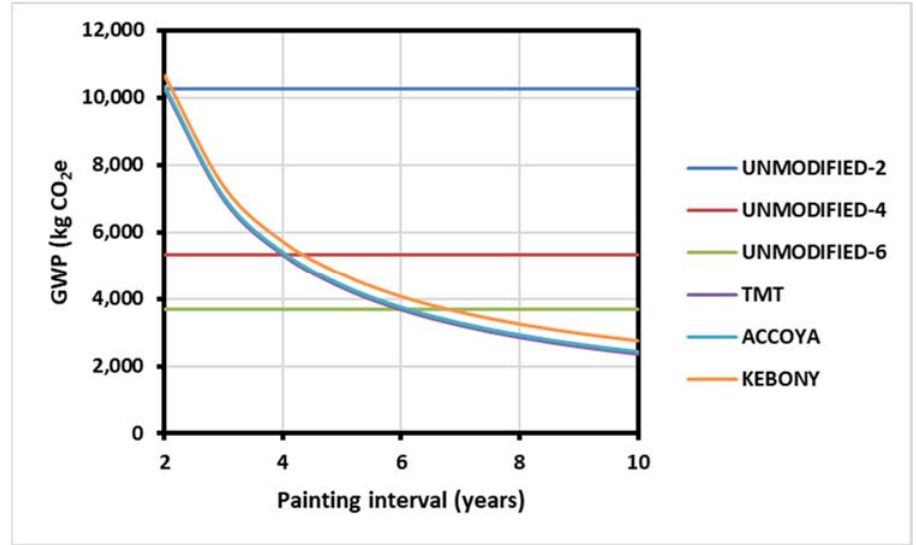
Figure 2. Effect of different coating intervals upon the GWP impact for unmodified and modified wood for a total area of 33.3 m 2 . For unmodified wood, the horizontal lines represent the impact for a single coating interval of 2, 4, or 6 years. A total lifetime of 60 years is considered and life-time of 20 years for the unmodified wood, and 60 years for the modified wood was